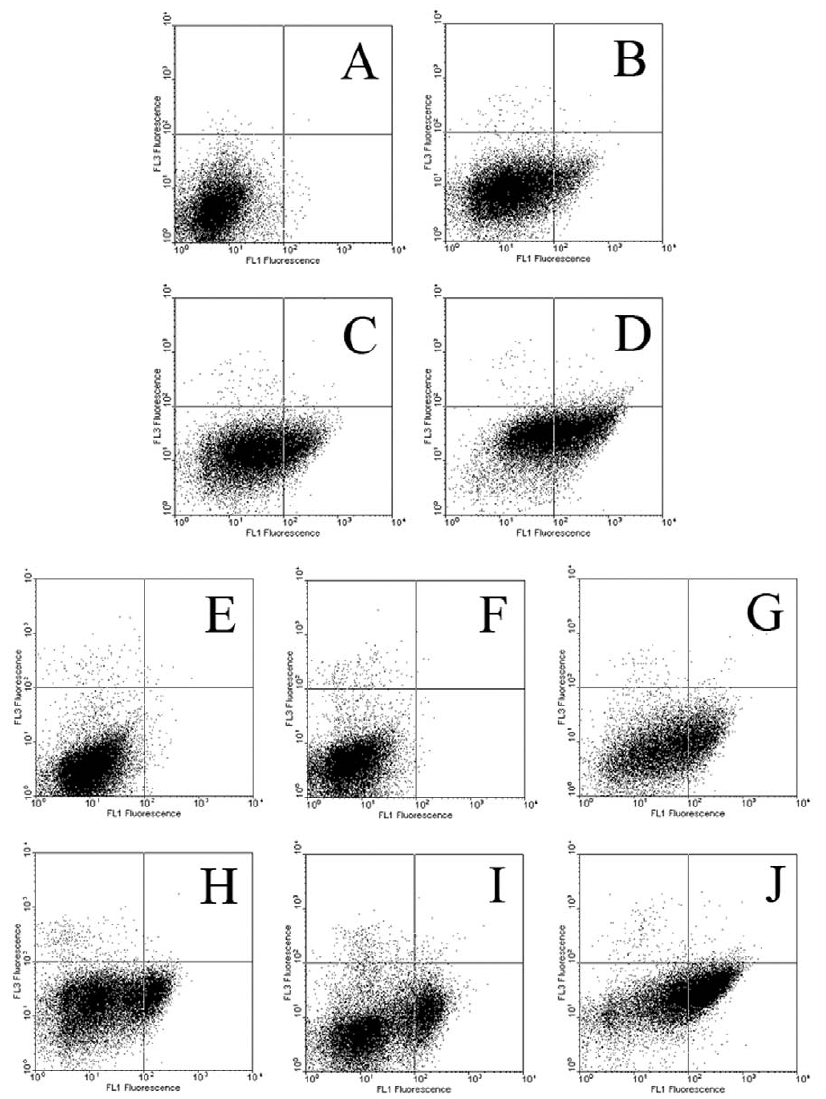
Figure 7. Apoptotic changes measured by flow cytometry. The first set of experiments included four groups: KTC-1 cells received no treatment ( A ), 20 MBq/ml 131 I ( B ), 5 m mol/L Bay 11-7082 ( C ) or combination ( D ) for 24 hours. Then cells were harvested by trypsinization, double stained by FITC-conjugated annexin V and propidium iodide, and then subjected for flow cytometry. In the second set of experiments, KTC-1 cells were first treated with no oligonucleotide control ( E ), scrambled oligonucleotides ( F ) or p65 siRNA transfection ( G ). Then these three groups of cells were exposed to 131 I (20 MBq/ml) for 24 hours ( H–J ). And flow cytometry was conducted. Similar results were obtained in three independent